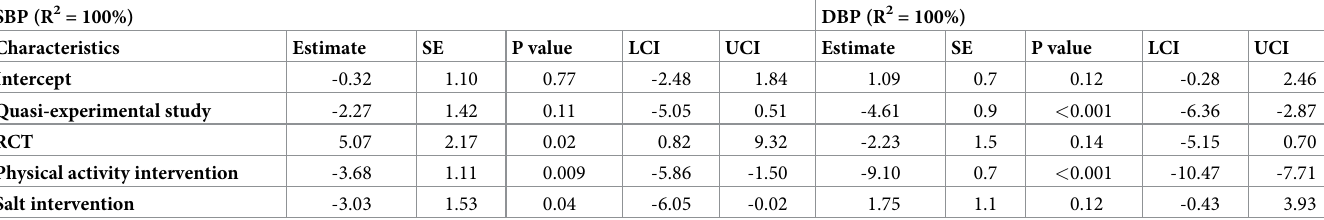
Table 2. Meta-regression analysis of study characteristics on average net reduction in blood pressure.